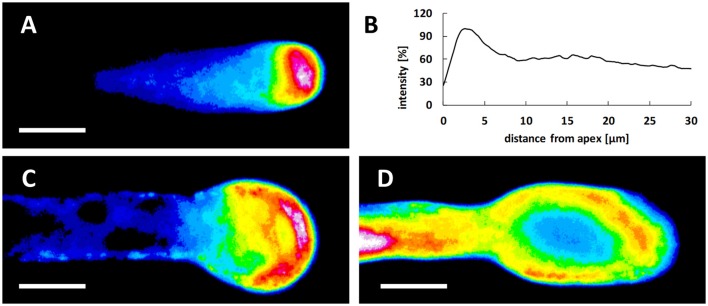
Treatment with Spm dramatically modifies the pH gradient at the pear pollen tube apex. (A) In controls, pollen tubes have a tip-oriented pH gradient with an acidic region located at the tube apex. The pH acid region disappears shortly after 5–10 μm from the apex and only a weak background signal can be observed. (B) The data is confirmed by the relative measurement of the fluorescence intensity that is representative of three independent experiments. (C) At the balloon stage of Spm-treated pollen tubes, the pH gradient changes and the highest H+ concentration is redistributed throughout the surface of the swelling apex. (D) At the shovel stage, H+ concentration is approximately homogeneous throughout the new enlarged pollen tube. No H+ accumulation was observed at the apex of the new pollen tube. Bar = 10 μm.